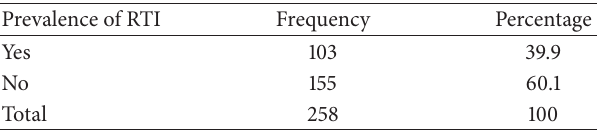
Table 1: Prevalence of symptoms suggestive of reproductive tract infections.